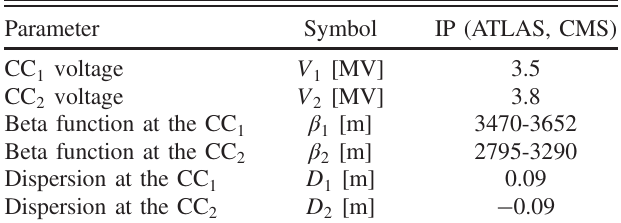
TABLE II. CCs parameters for the HL-LHC. Subscript 1 refers to the CCs that open the crab bump and subscript 2 refers to the CCs which close it.